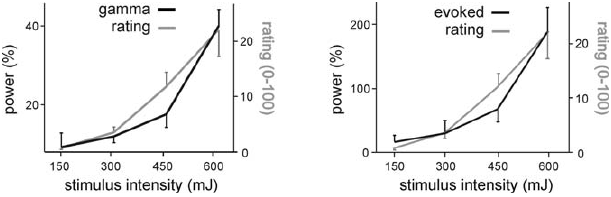
Figure 3. Pain Intensity, Amplitudes of Induced Gamma Oscillations, and Amplitudes of Evoked Responses as a Function of Stimulus Intensity Mean power changes of induced gamma oscillations (black line, left panel) and evoked activity (black line, right panel) at 100–300 ms with respect to baseline were computed for all four stimulus intensities and compared to mean pain ratings (gray lines). Error bars depict 6 the standard error of the mean (s.e.m.) Induced gamma oscillations, evoked responses, and pain intensity increase with stimulus intensity. Spear- man’s correlation coefficient between induced gamma oscillations and pain intensity was 0.96 ( p ¼ 0.003), and between evoked responses and pain intensity was 0.99 ( p ¼ 0.012). doi:10.1371/journal.pbio.0050133.g003 PLoS Biology |